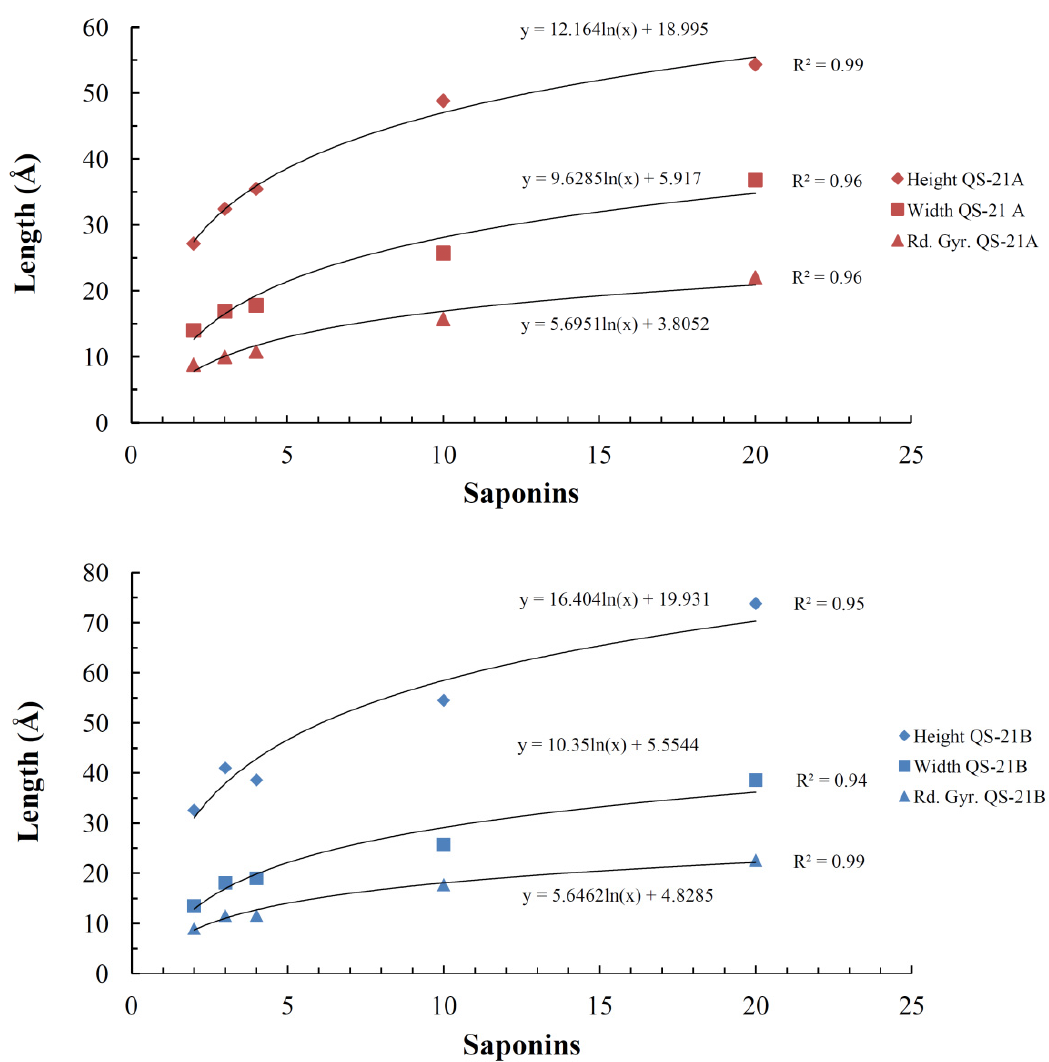
Figure 6. Average dimensions for each micelle pertaining to the independent simulations of QS-21 A and QS-21